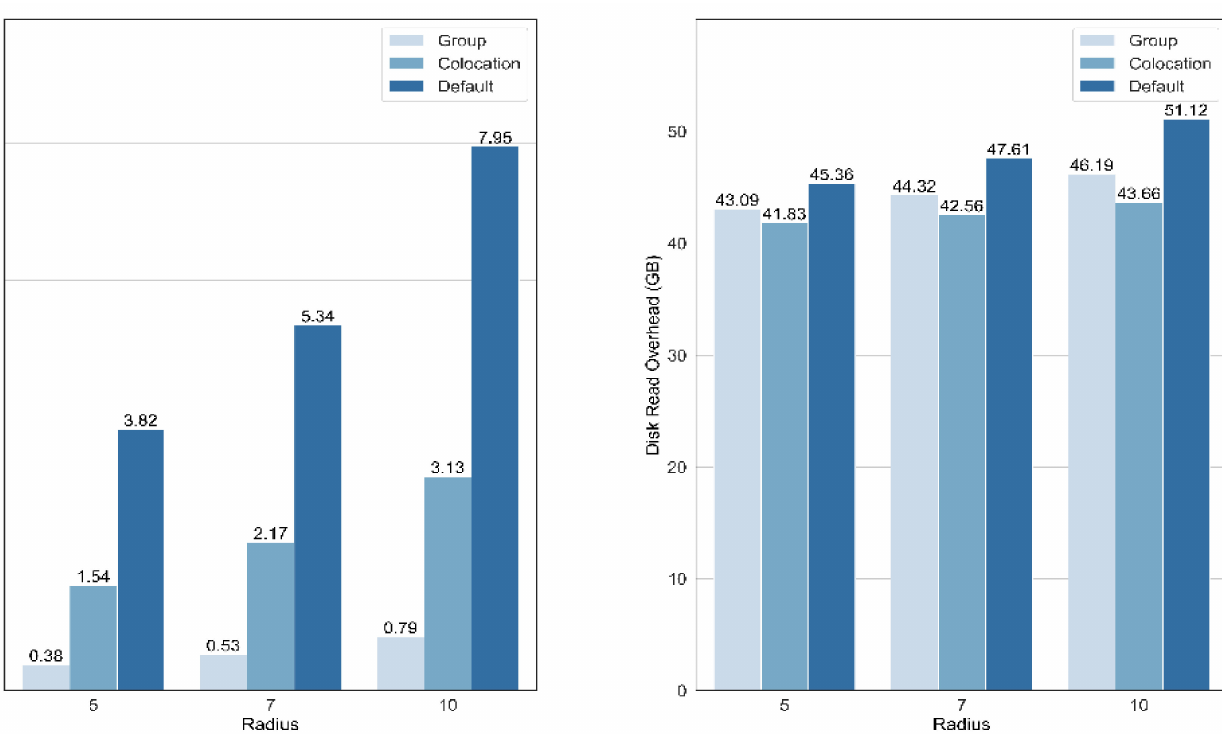
Figure 6. IO performance of the group-based method, the colocation-based method, and the default Hadoop replica placement policy. Network and disk read overheads are compared among these